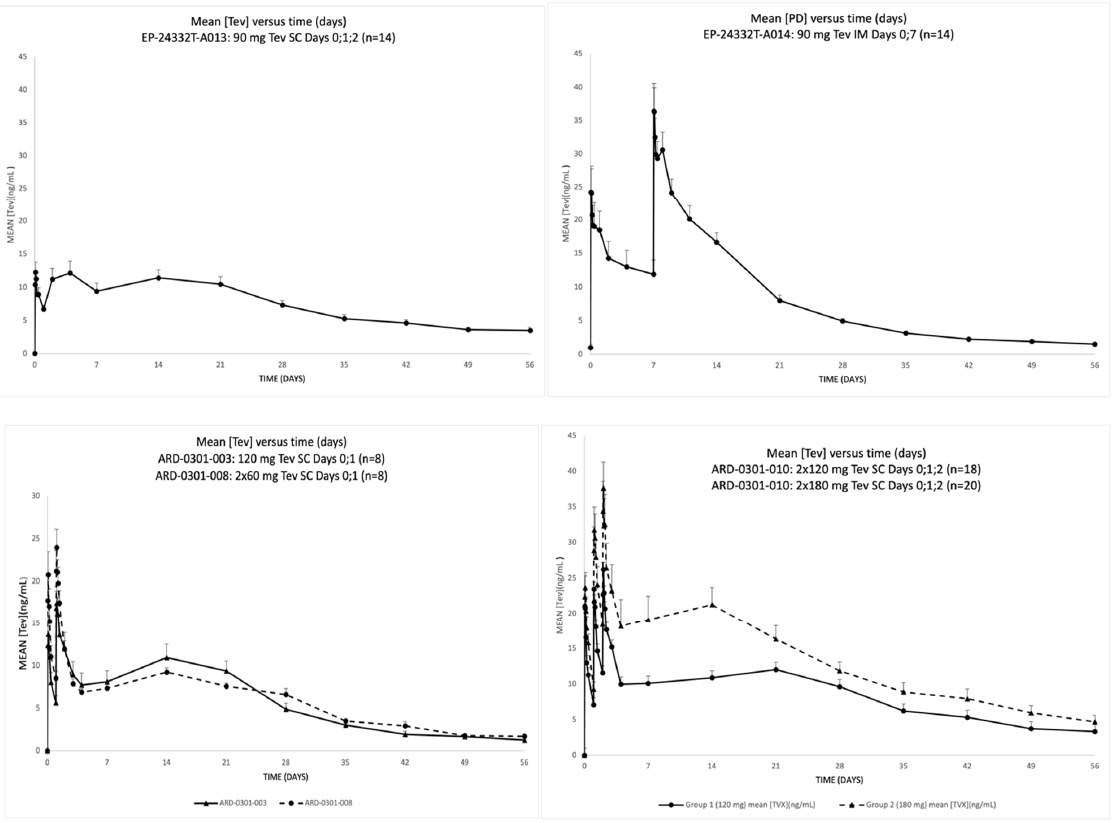
Figure 2. Mean teverelix DP concentration (ng/mL)(+SEM) vs. time (days). IM = intramuscular; SC = subcutaneous.